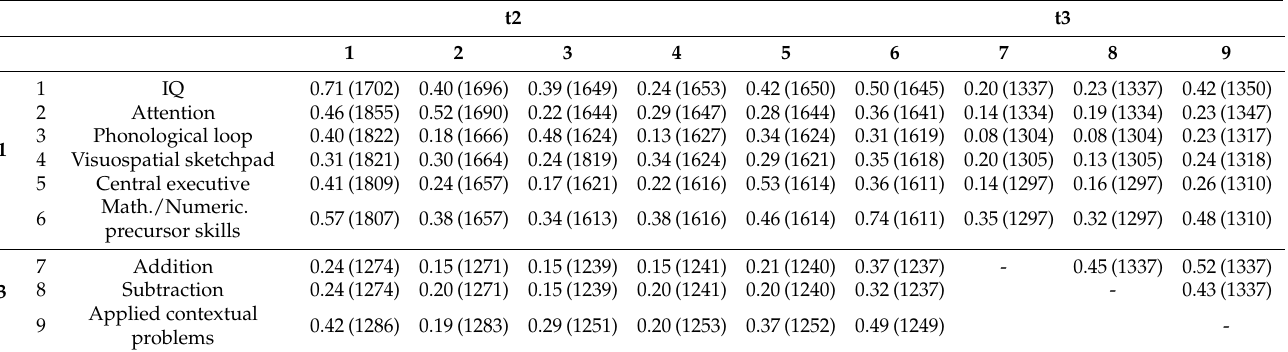
Table 5. Pearson Correlations across the three time points: t1, t2 and t3 ( n ). t2